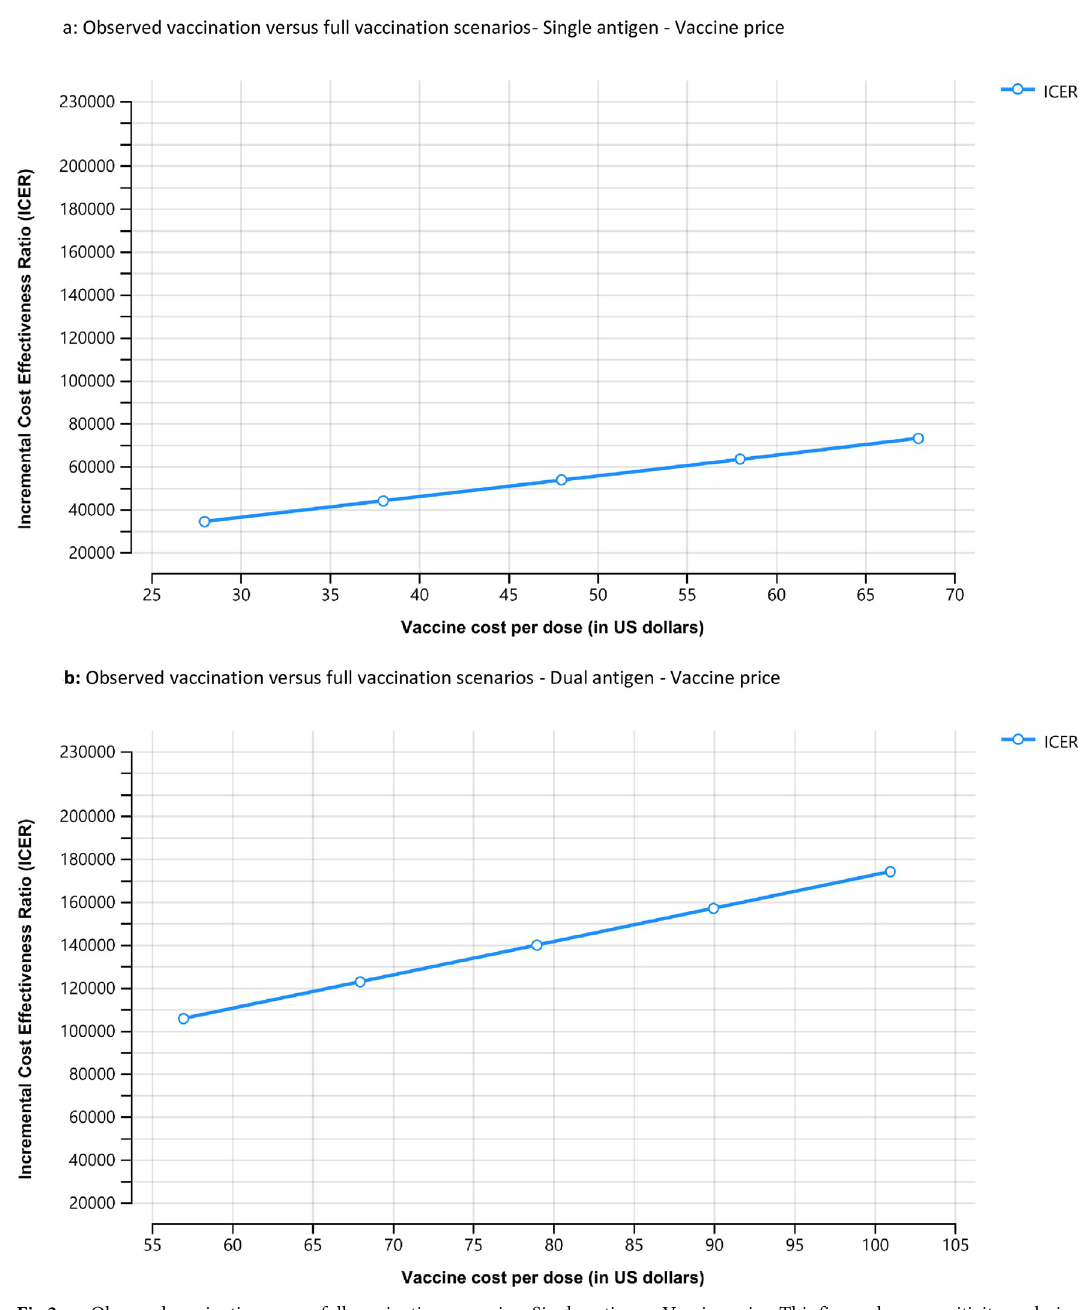
Fig 3. a. Observed vaccination versus full vaccination scenarios- Single antigen—Vaccine price. This figure shows sensitivity analysis based on vaccine cost per dose comparing observed vaccination with full vaccination for the single antigen vaccine. The Y axis represents the incremental cost effectiveness ratio (ICER). The X axis represents the range of vaccine cost per dose in US dollars between $25 and $70. b. Observed vaccination versus full vaccination scenarios- Dual antigen—Vaccine price. This figure shows sensitivity analysis based on vaccine cost per dose comparing observed vaccination with full vaccination for the dual antigen vaccine. The Y axis represents the incremental cost effectiveness ratio (ICER). The X axis represents the range of vaccine cost per dose in US dollars between $55 and